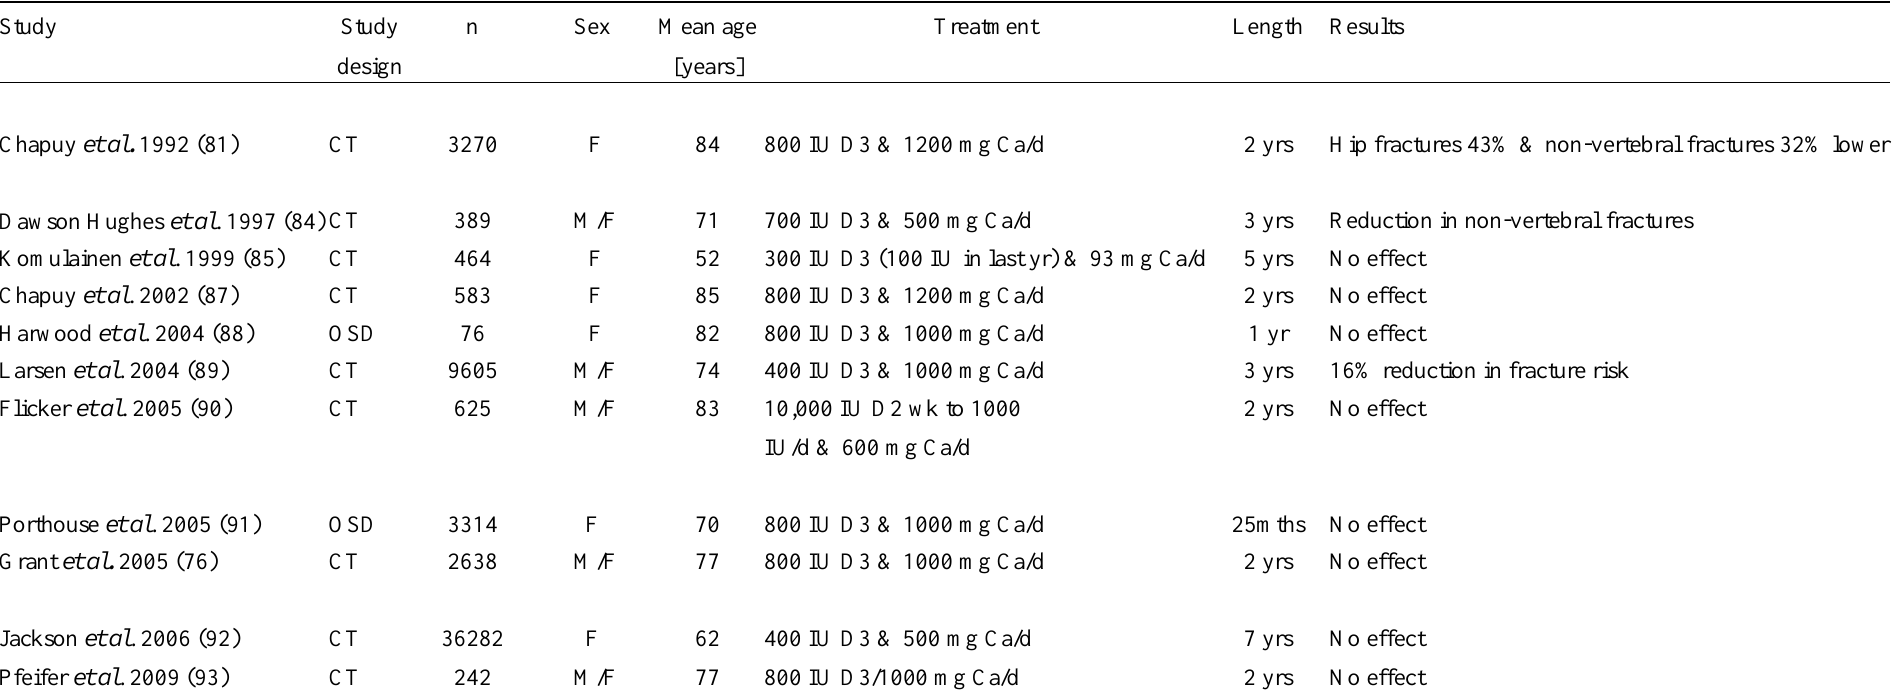
Table 2. Interventionwith vitamin D plus calcium on fracture